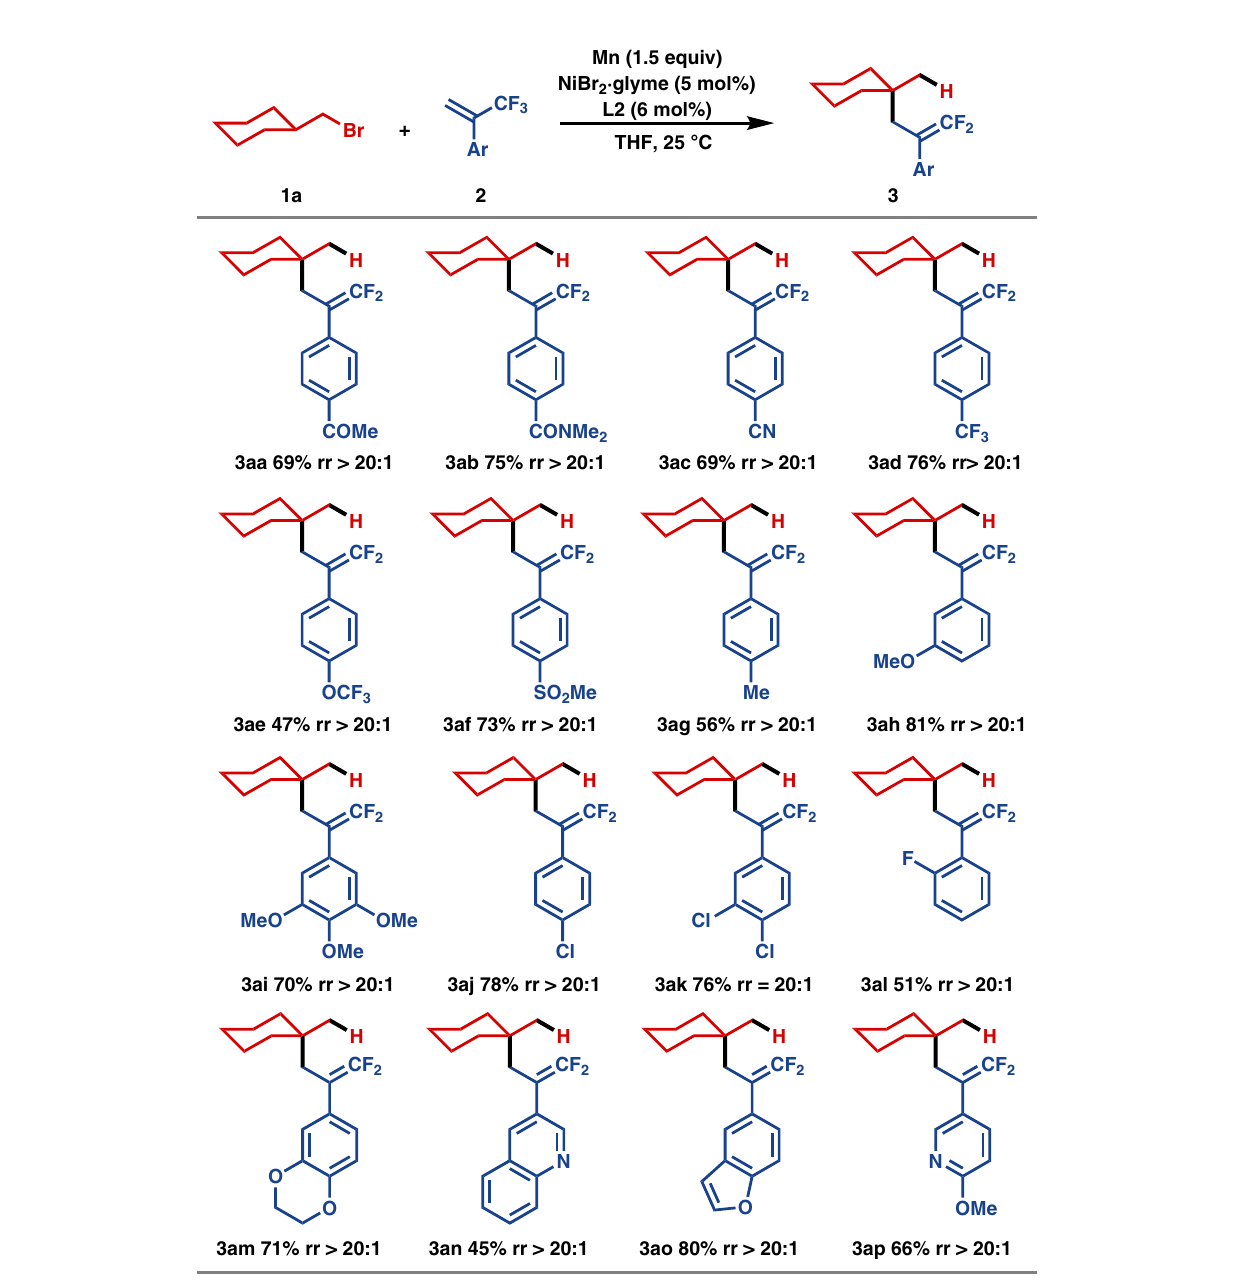
Table 3 Scope with tri fl uoromethyl alkenes a